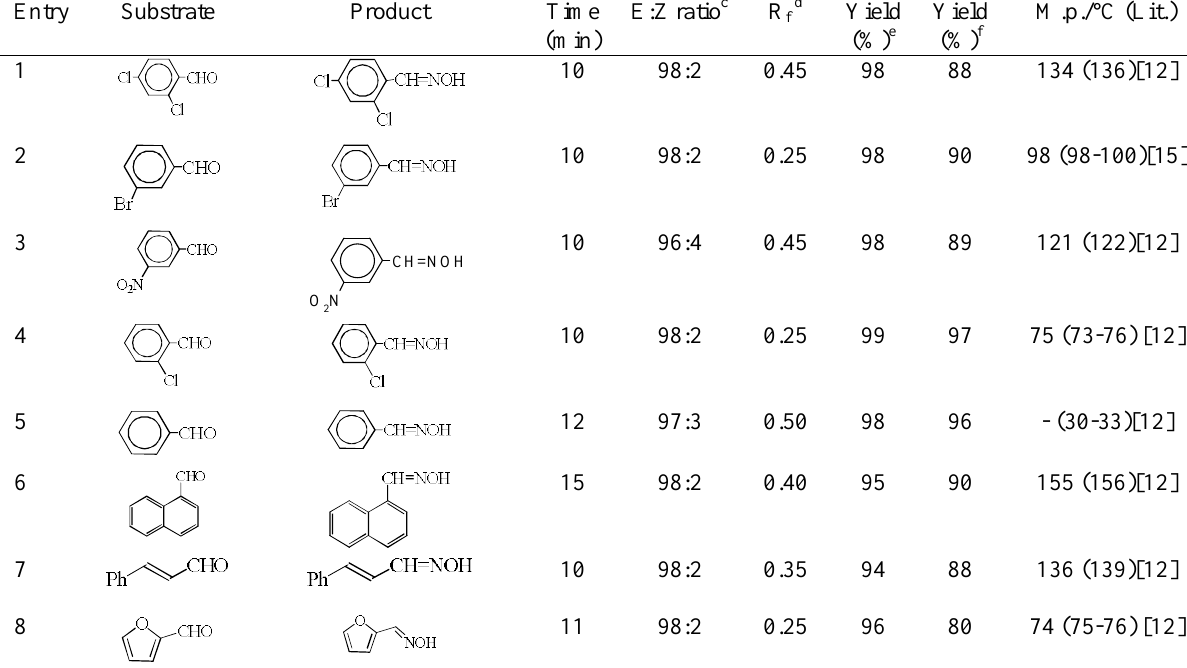
Table 2. Oximation of Aldehydes with NH Entry